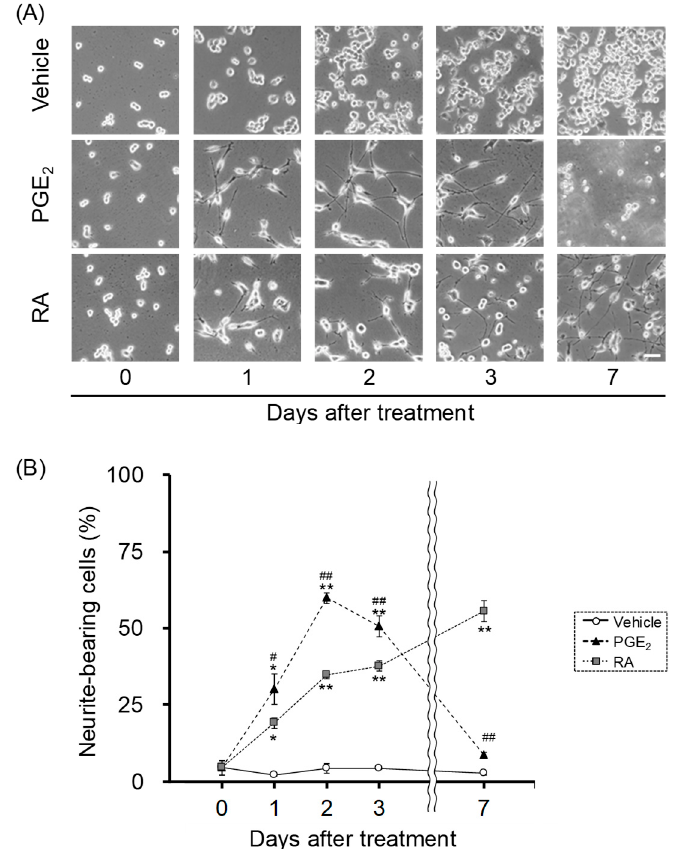
Figure 1. The effects of prostaglandin E 2 (PGE 2 ) and retinoic acid (RA) on neurite outgrowth. Undifferentiated NSC-34 cells were treated with a vehicle (EtOH), 30 μ M PGE 2 or 10 μ M RA. ( A ) Photographs show typical phase-contrasts in each treatment group. Scale bar indicates 50 μ m. ( B ) Graph shows the quantitative analysis of cells bearing neurite, expressed as the percentage of cells bearing neurites. Each value represents the mean ± SEM ( n = 4). * p < 0.05, ** p < 0.01 vs. vehicle-treated cells at same day. # p < 0.05, ## p < 0.01 vs. RA-treated cells at same day.